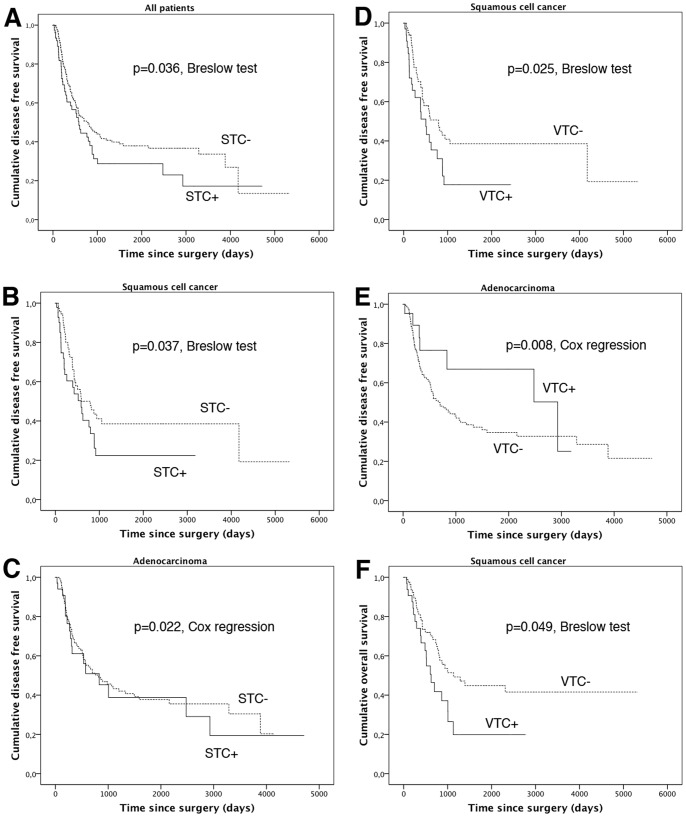
Kaplan Meier curves of disease free (DFS) and overall survival (OS) of esophageal cancer patients.
Fig.2A: Presence of stromal thrombocytic clusters (STC) was associated with shorter DFS in all cases. At investigation of tumor types separately, STC was associated with shorter DFS in squamous cell cancer (SCC) (Fig. 2B) as well as in adenocarcinoma (AC) (Fig. 2C). Fig. 2D: Presence of vascular thrombocytic clusters (VTC) was associated with shorter DFS in SCC. Fig. 2E: Surprisingly, VTC was associated with significantly longer DFS in AC in multivariate analysis. Nevertheless, note that only relatively few events are seen in the VTC+ curve, and curves are crossing each other over, qualifying this finding. Fig. 2F: VTC was associated with shorter OS in SCC.